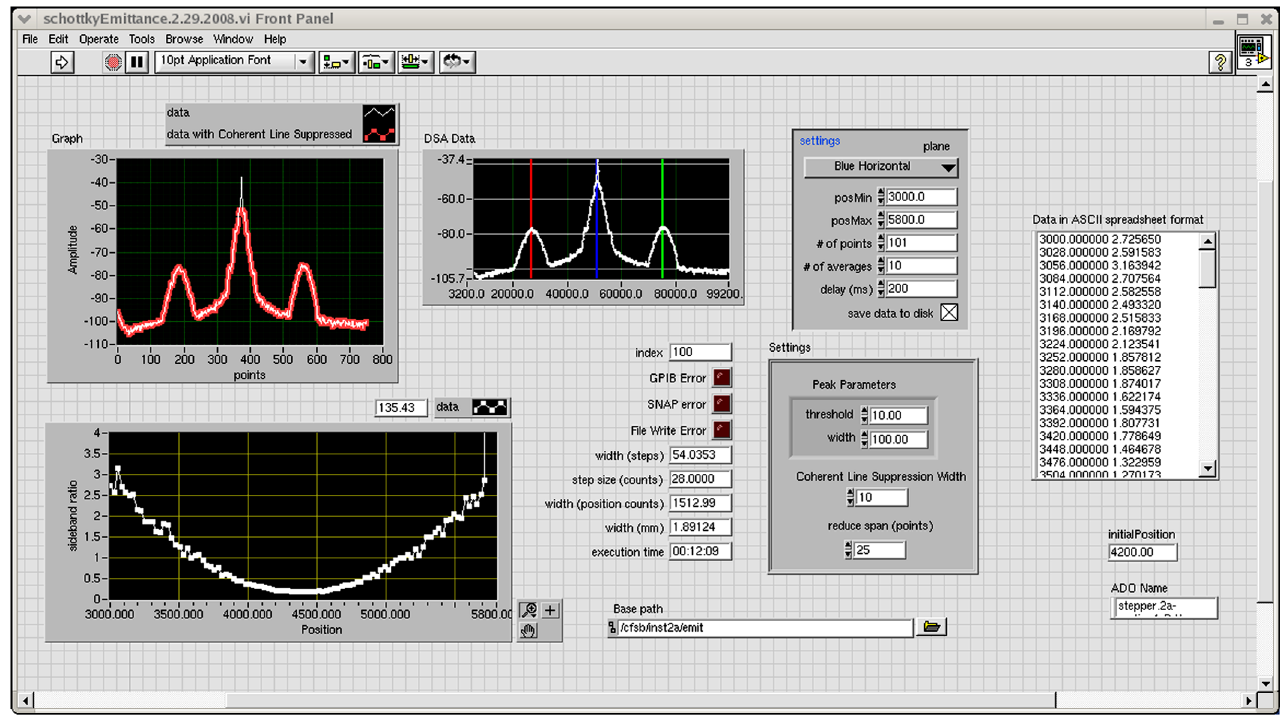
FIG. 3. (Color) LABVIEW (cid:2) application used to scan the position of the detector and measure the power in the Schottky spectral